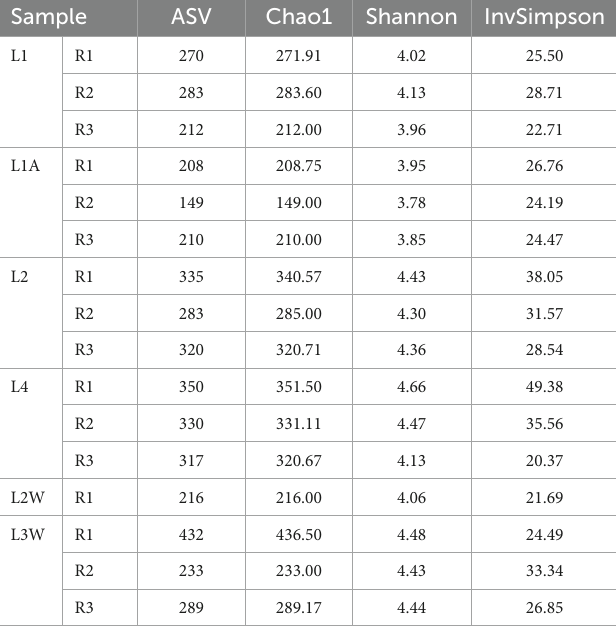
TABLE 2 Characteristic of diversity richness among cave sediment and water samples from Leșu Cave (R1, R2, R3 represent the number of replicates for each